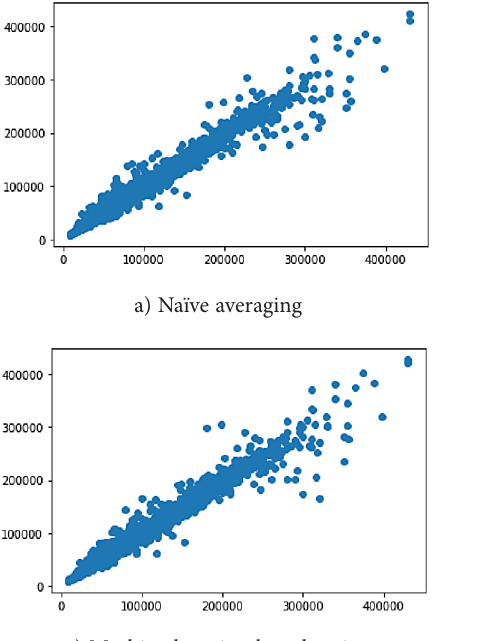
c) Machine learning-based voting d) Figure 8. Scatter plots of the actual contract prices (depicted on the horizontal axis) and the predicted values (shown on the vertical axis) of the combined predictors